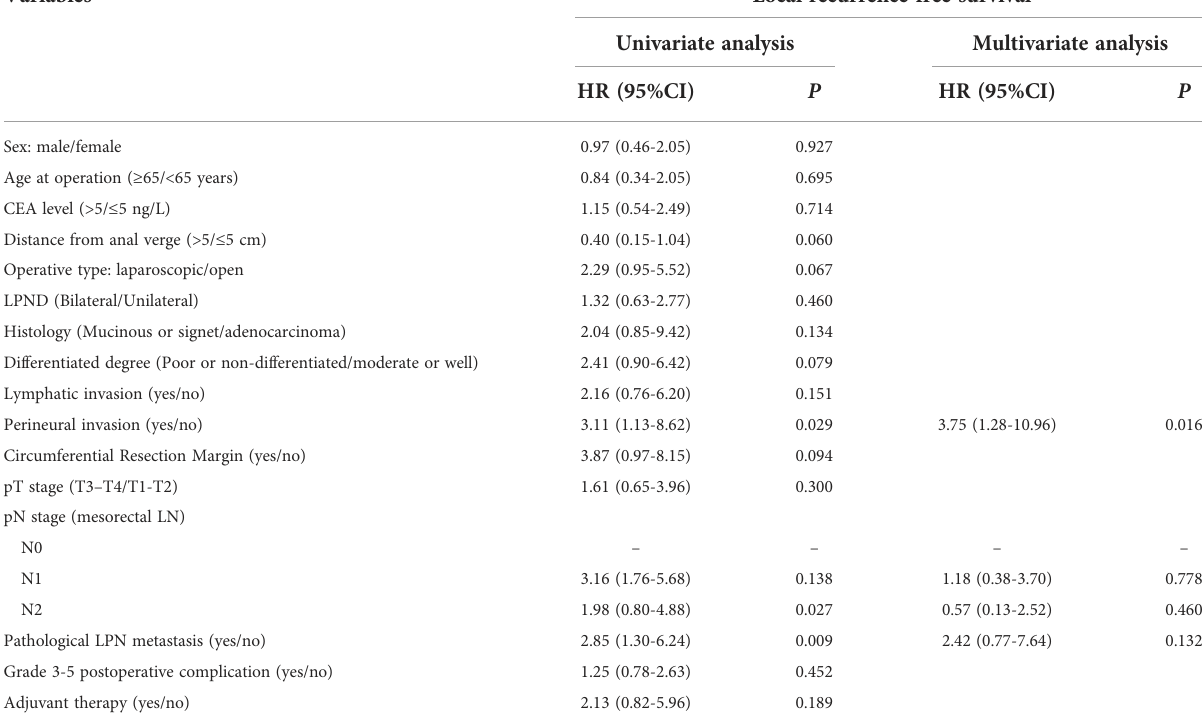
TABLE 4 Univariate and multivariate regression analyses of local recurrence-free survival in 387 patients with clinical LPN metastasis who underwent TME+LPND.